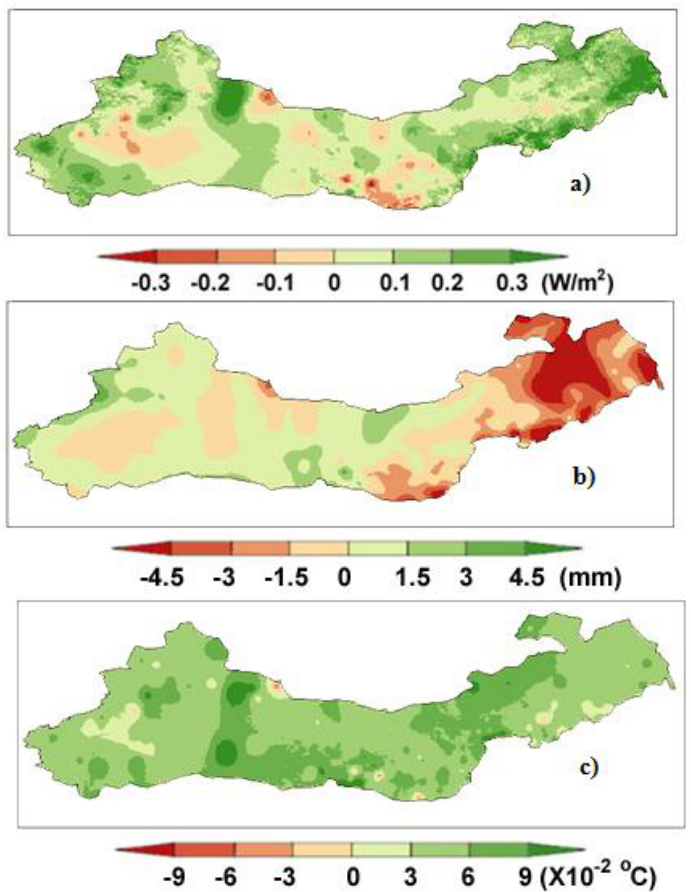
Figure 8. Spatial pattern of linear trends in annual ( a ) LE based on MS-PT algorithm driven